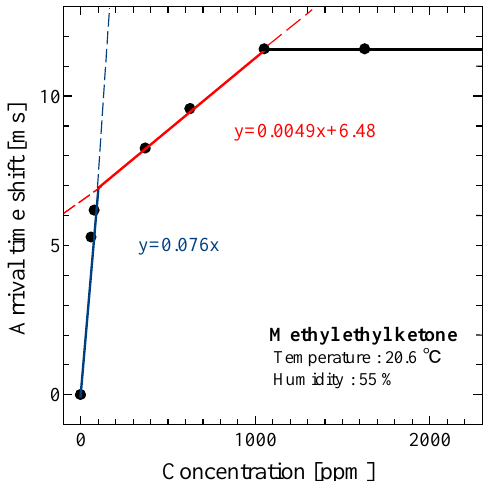
Figure 5. Relationship between concentration and arrival-time shift for MEK. The measurement error of the flow rate was estimated to be ~3%.